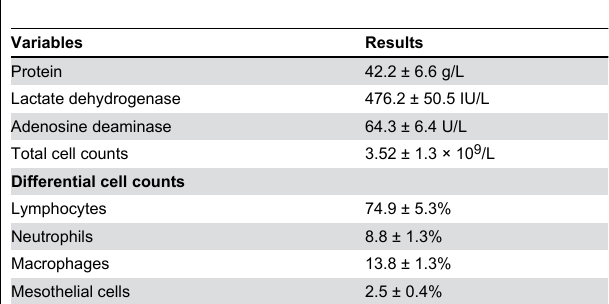
Table 1. Biochemical and cytological characteristics in tuberculous pleural effusion.